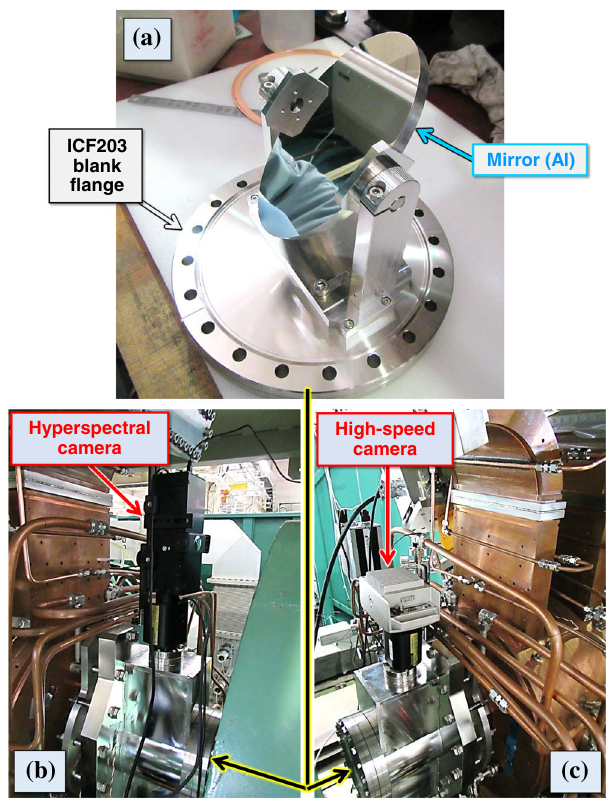
FIG. 4. (a) Elliptical mirror made of aluminum. Setup of the mirror chamber with (b) a hyperspectral camera or (c) a high- speed camera mounted on the view port of the mirror chamber.